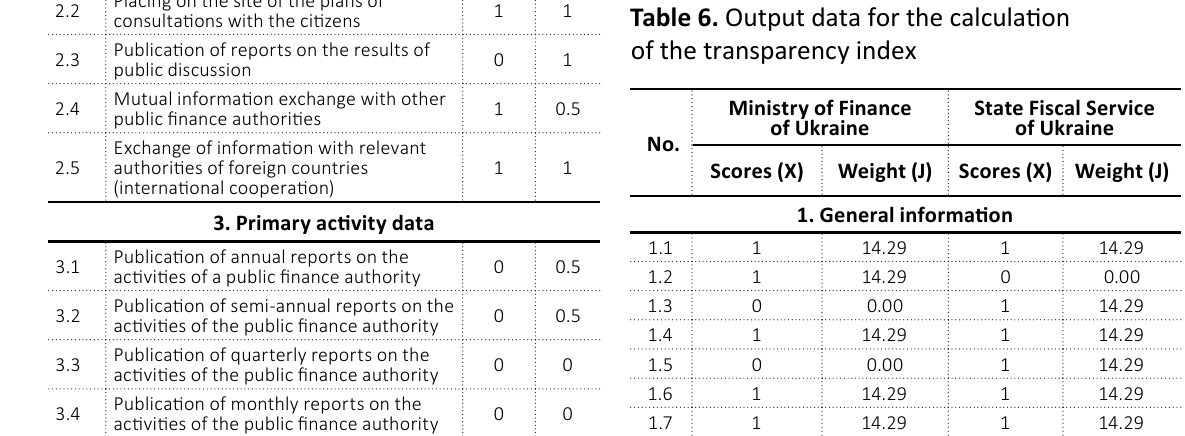
Table 6. Output data for the